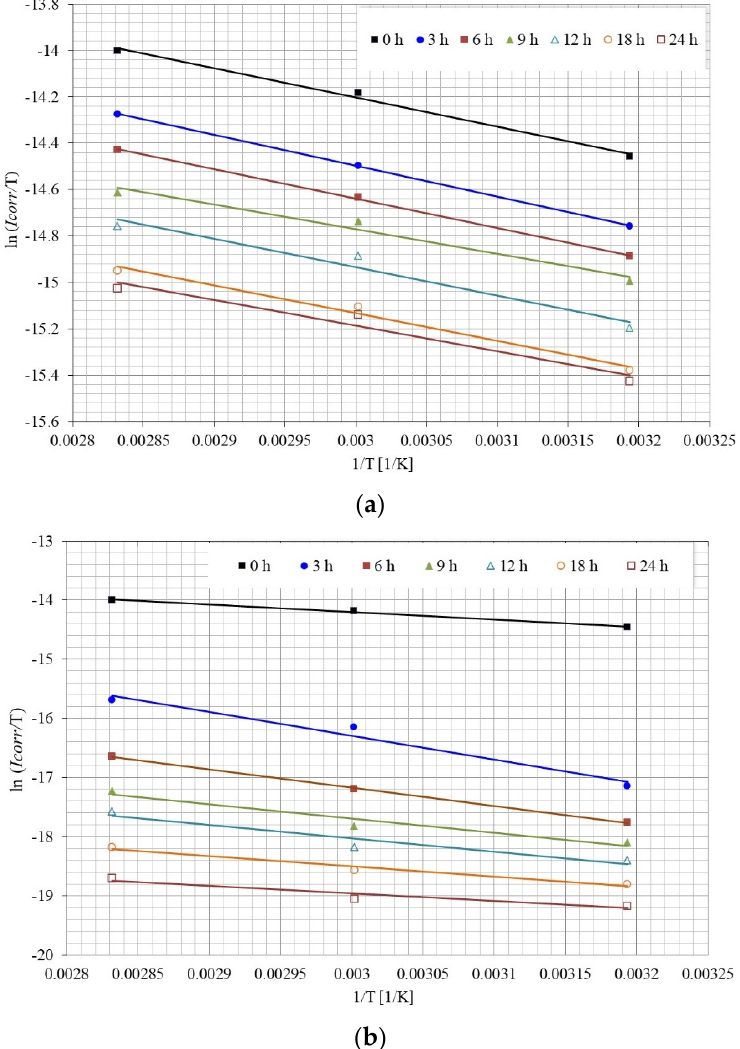
Figure 15. Arrhenius plot, for the calculation of Δ H° and Δ S°, as a function of immersion time: ( a ) without inhibitor, ( b ) with 25 ppm inhibitor.